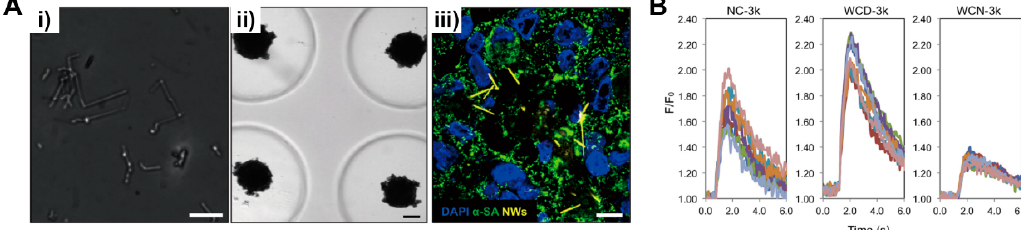
Figure 13. ( A ) Representative image of silicon nanowires (i), silicon nanowired (e-SiNW) human cardiac spheroids, (ii) and immunofluorescence image of a frozen section of spheroids (Blue-DAPI; Green-alpha sarcomeric actinin; Yellow-silicon nanowires) (iii). ( B ) Measurement of Calcium transient of spheroids by fluorescence intensity (NC-without e-SiNWs; WCD-with doped SiNWs; WCN-with undoped SiNWs). Scale bar: 10 μ m for (( A ) i and iii), 100 μ m for (( A ) ii). Reprinted from [94].